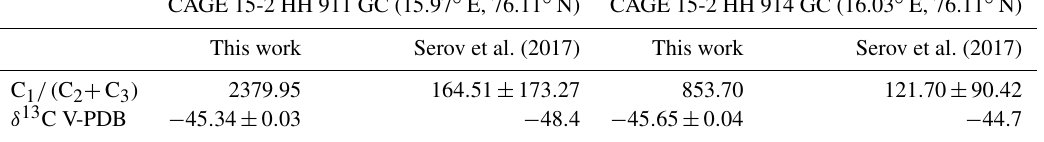
Table 2. Gas composition of hydrate and gravity core samples by mass from the Storfjordrenna hydrate pingo area according to this work and Serov et al.